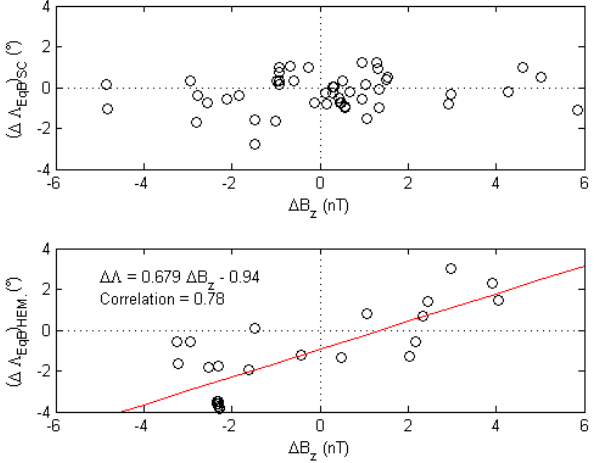
Fig. 11. Variations of the location of the cusp equatorward boundary versus variations in IMF- B z . As in Fig. 7, the top panel shows vari- ations between pairs of spacecraft crossing the same cusp, whereas the bottom panel shows variations between the southern and the northern cusps on the same orbit. Only cases occurring under steady or rotating IMF are